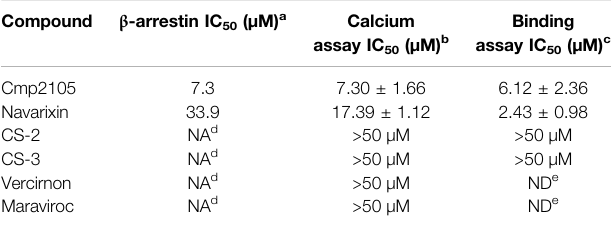
TABLE 1 | CCL19 competition binding, CCR7 calcium mobilization and CCR7 β - arrestin data of reference compounds.